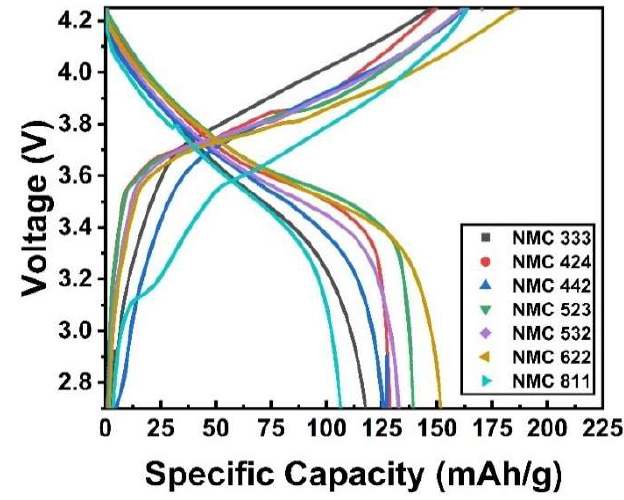
Figure 8. Charge–discharge analysis of as-prepared samples. The specific discharge capacity of NMC 333, NMC 424, NMC 442, NMC 523, NMC 532, NMC 622 and NMC811 is 120.20 mAh/g, 129.43 mAh/g, 127.30 mAh/g, 140.04 mAh/g, 134.22 mAh/g, 153.60 mAh/g and 106.30 mAh/g, respectively, as shown in Figure 8. NMC622 delivers a higher specific discharge capacity due to its high nickel content; mean- while, NMC811 needs different synthesis conditions. NMC cathode material has active electrochemical ions, Ni 2+ and Co 3+ . The oxidation of Ni 2+ must follow charge com- pensation during lithium extraction (i.e., charging) to Ni 3+ and Ni 4+ , and Co 3+ to Co 4+ , respectively [56]. Since the Ni 3+ and Ni 4+ ions are converted to Ni 2+ ions when heated, oxygen release from the structure is unavoidable to maintain charge neutrality. The tem- perature ranges for the LiMn 2 O 4 -type and Mn 3 O 4 -type spinel for each sample are similar to the temperature range for oxygen release spreading. The lower the onset temperature